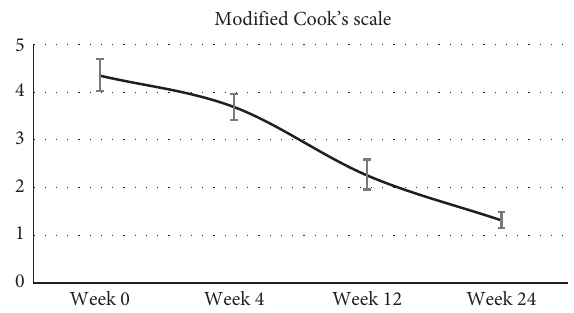
Figure 4: Global acne assessment using modified Cook’s scale: The data represent the modified Cook’s scale analysis made during each visit (at week 9, week 4, week 12, and week 24). The error bars are average ± SEM.